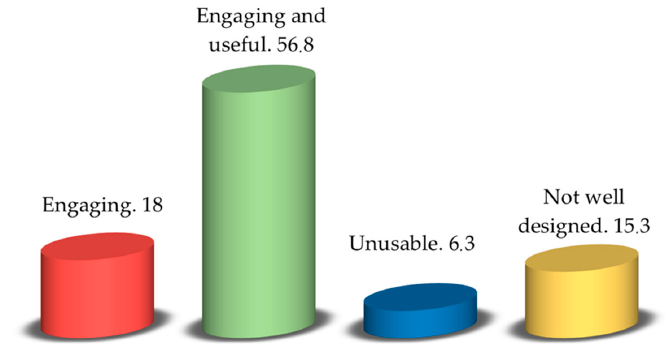
Figure 2. Student in percentage rating the use of active methodologies during the lockdown.